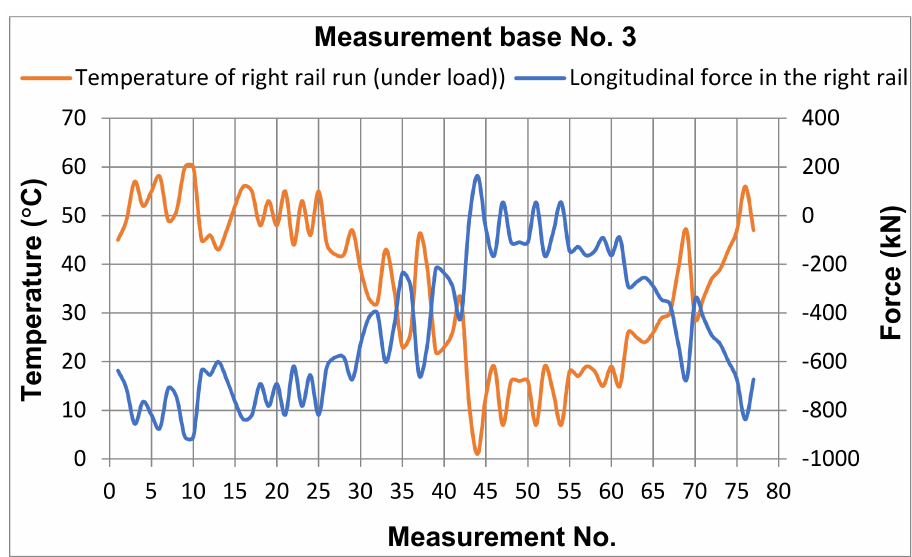
Figure 11. Results of measurements of temperature and longitudinal force of the right rail after loading by a passing train—measurement base No. 3 (source: own